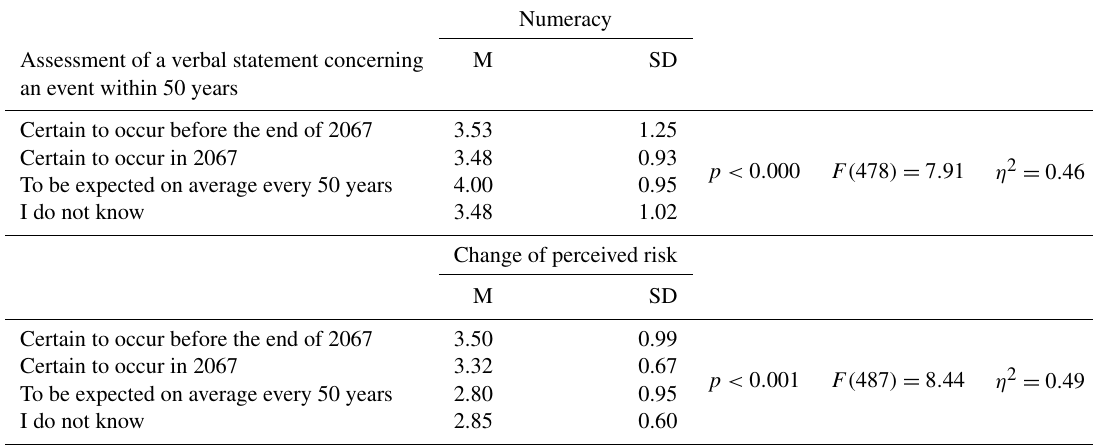
Table 11. Univariate analysis of variance with numeracy or the change of risk perception as dependent variable and the assessment of a verbal statement about an event within 50 years as independent variable ( N =